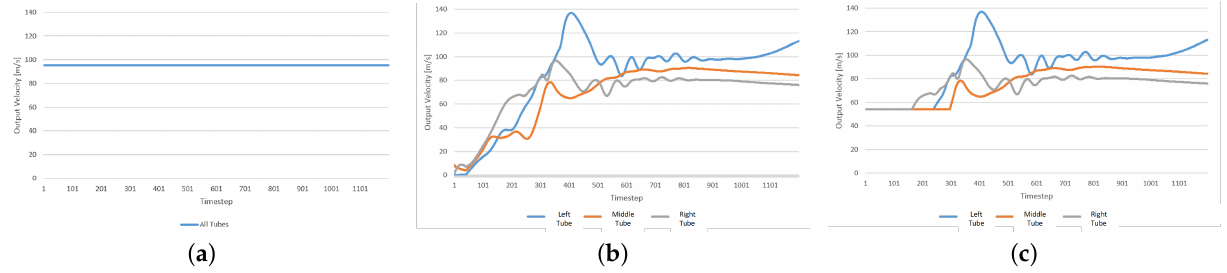
Figure 7. Flow velocity output value for the one-finger condition. (a) Constant ; (b) FlowEst1 ; (c) FlowEst2 .